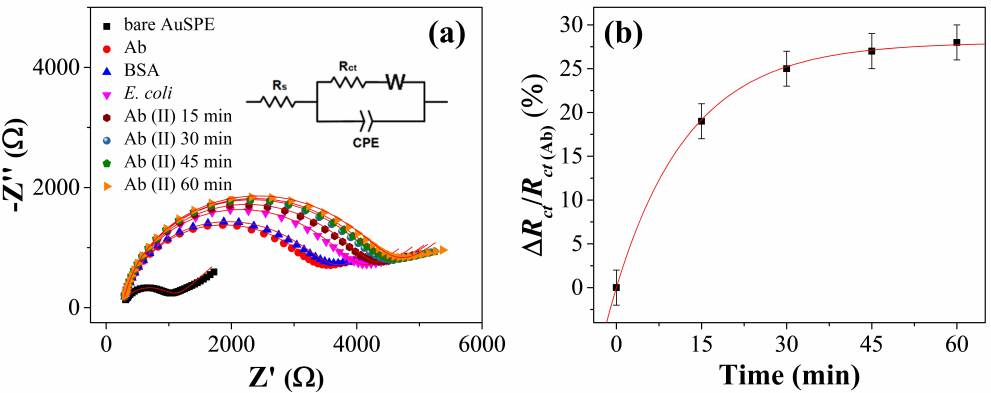
Figure 5. Kinetics of the secondary antibody. ( a ) EIS spectrum measured at di ff erent times while a 25 µ g mL − 1 Ab solution is conveyed to the cell after the detection E. coli (10 5 CFU mL − 1 ); ( b ) R ct as a function of time showing an exponential dynamic with a constant time of 13.5 ± 0.3 min.